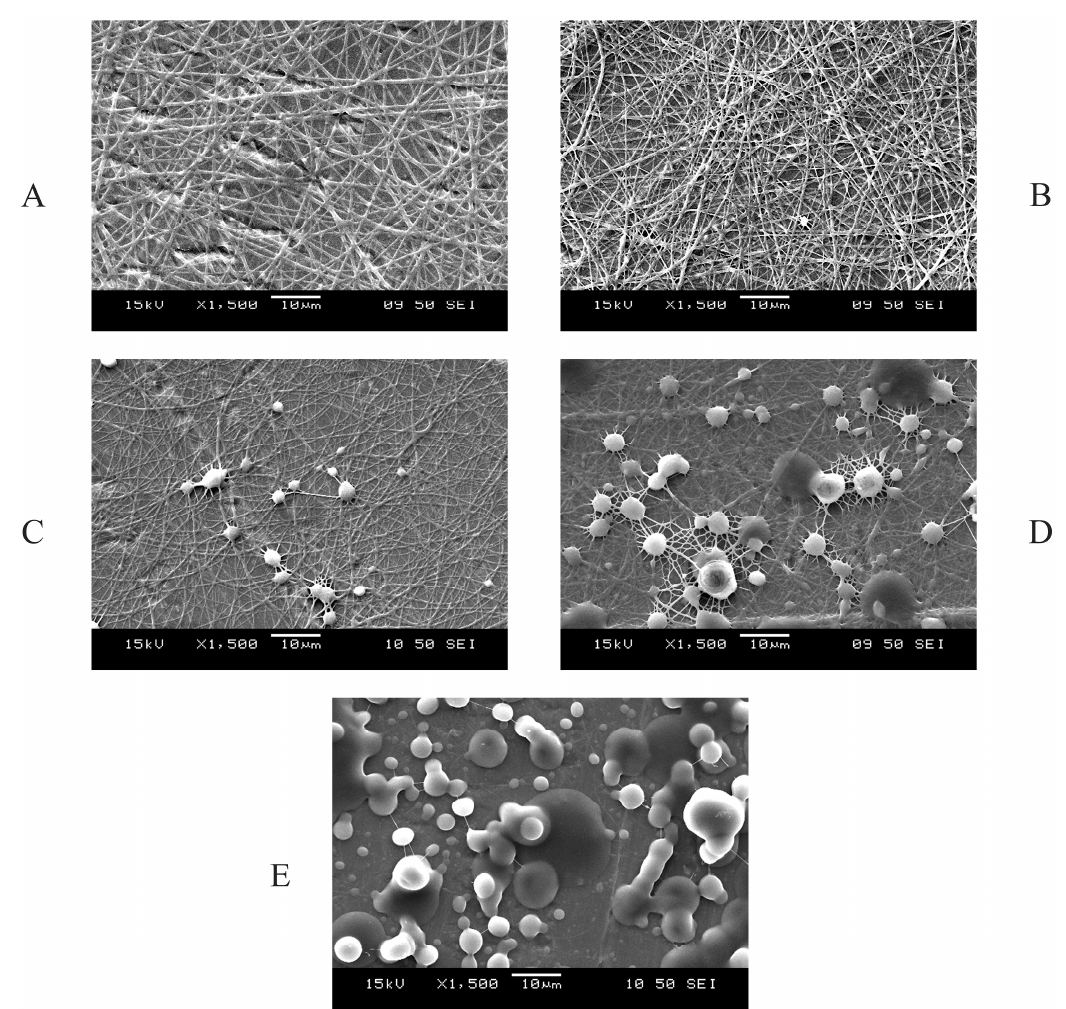
Figure 4. SEM images of the fibers consisting of different HPC-PVP molar ratios. ( A ) HPC-PVP = 5:5 molar ratio; ( B ) HPC-PVP = 6:4 molar ratio; ( C ) HPC-PVP = 7:3 molar ratio; ( D ) HPC-PVP = 8:2 molar ratio; ( E ) HPC-PVP = 9:1 molar ratio.